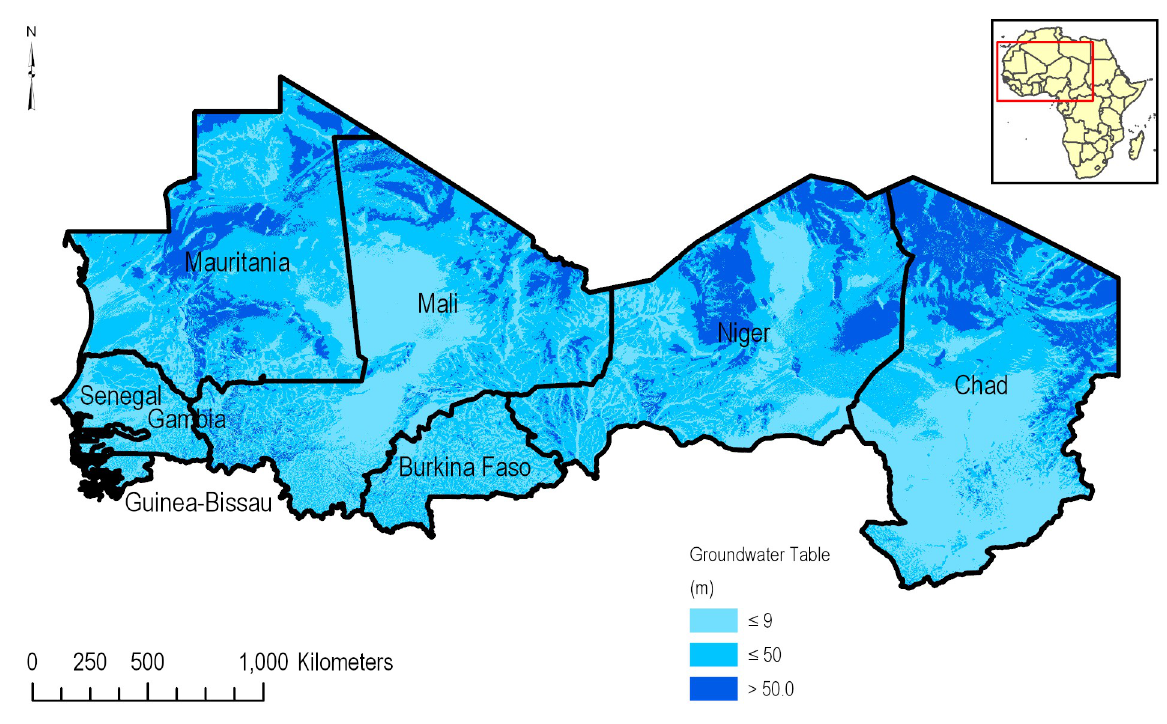
Fig 7. Spatial distribution of groundwater depth in the CILSS